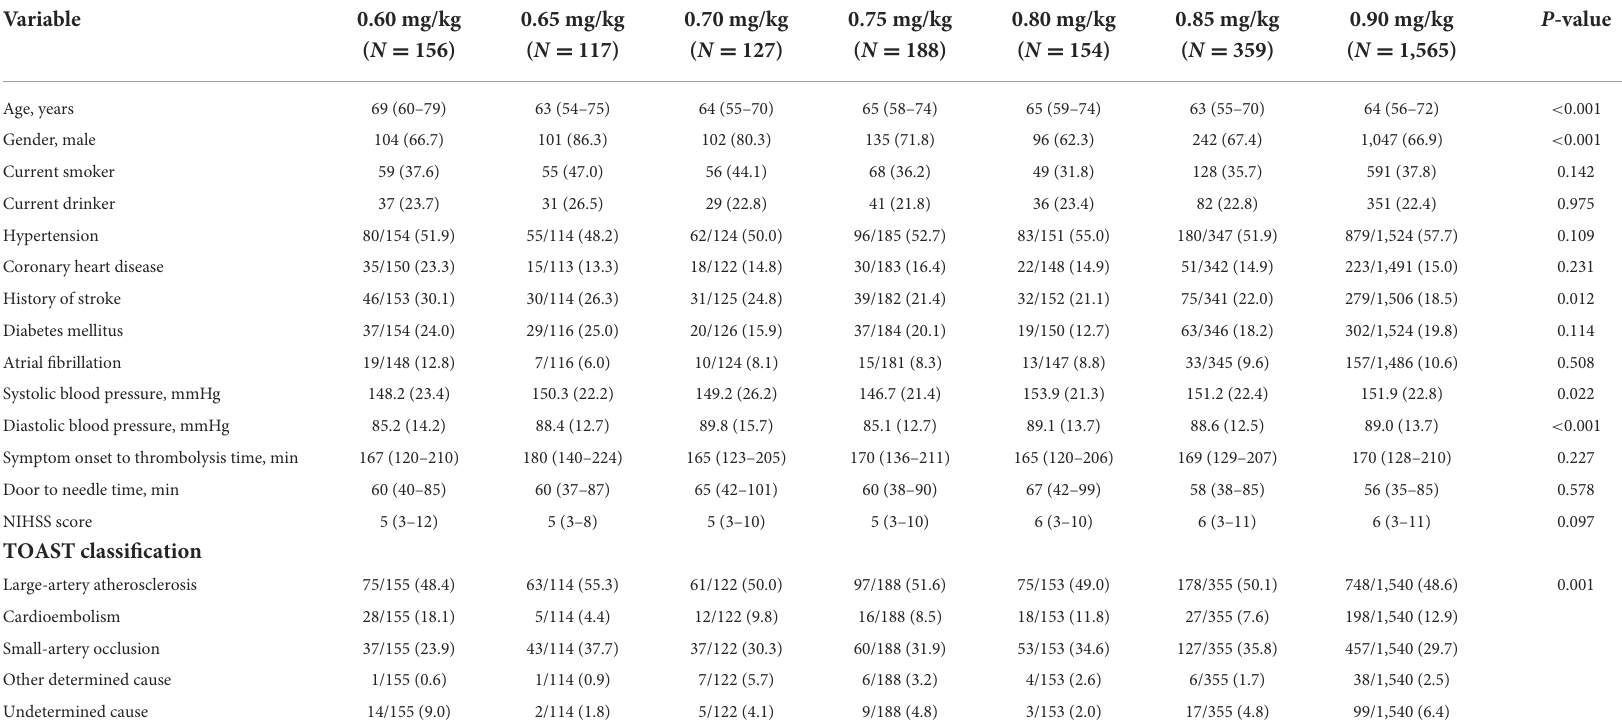
TABLE 1 Baseline characteristics of patients in multi-dose r-tPA